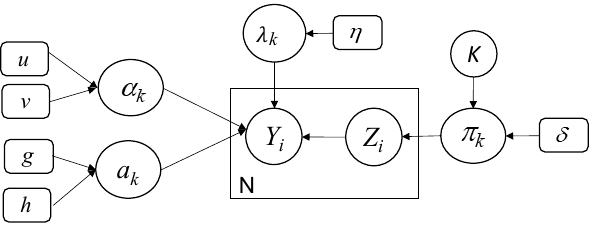
Figure 1. Graphical representation of our developed Bayesian finite shifted-scaled Dirichlet mixture model. Fixed hyperparameters are indicated by rounded boxes and random variables by circles. Y is the observed variable, Z represents the latent variable, the large box indicates repeated process, and the arcs show the dependencies between